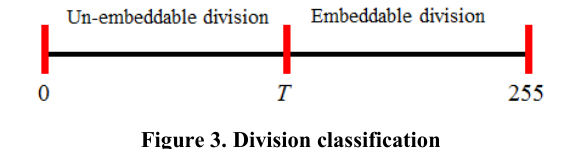
Figure 3. Division